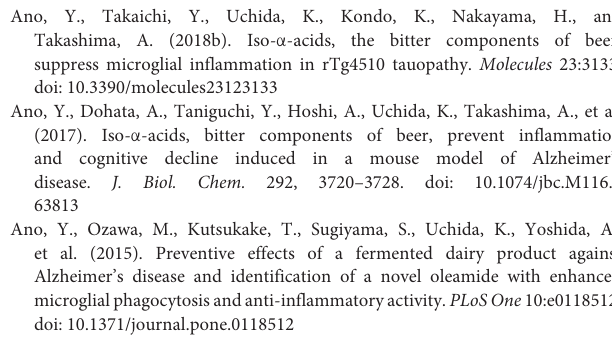
FIGURE S1 | Weight and food/water consumption in aged mice. We fed C57BL/6J mice aged 7 weeks (young; n = 12) and 68 weeks (aged) diets containing 0% or 0.05% (w/w) IAA for 3 months (aged with dietary IAA, n = 10; aged without dietary IAA, n = 9). (A) Body weight was monitored every